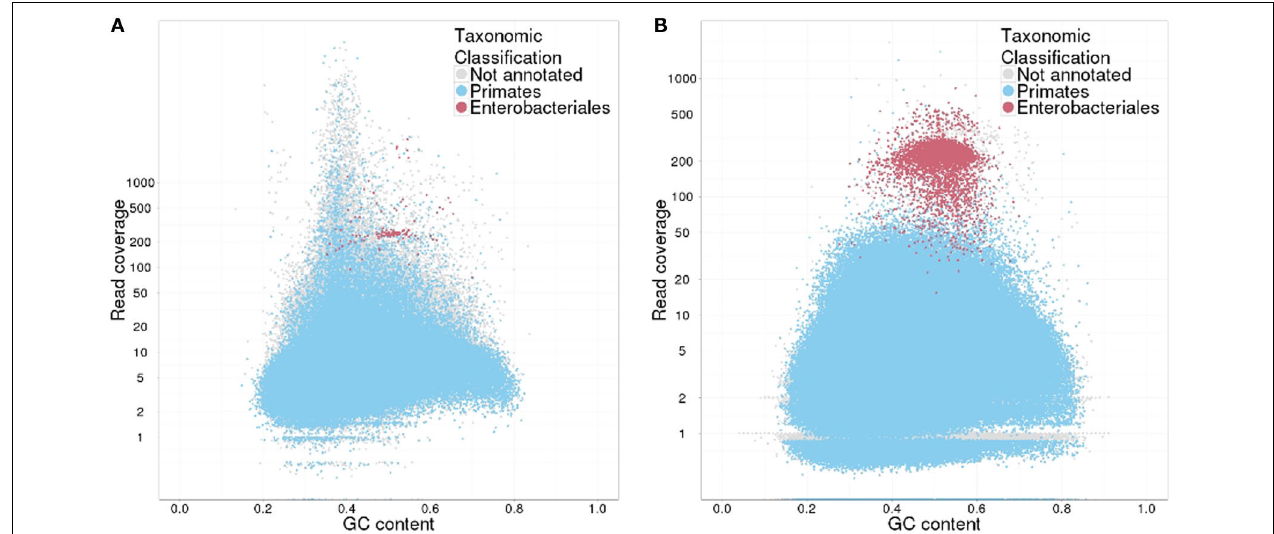
axis) and read coverage (Y axis, logarithmic scale). Contigs are colored according to the taxonomic order of the best megablast match to the NCBI nt